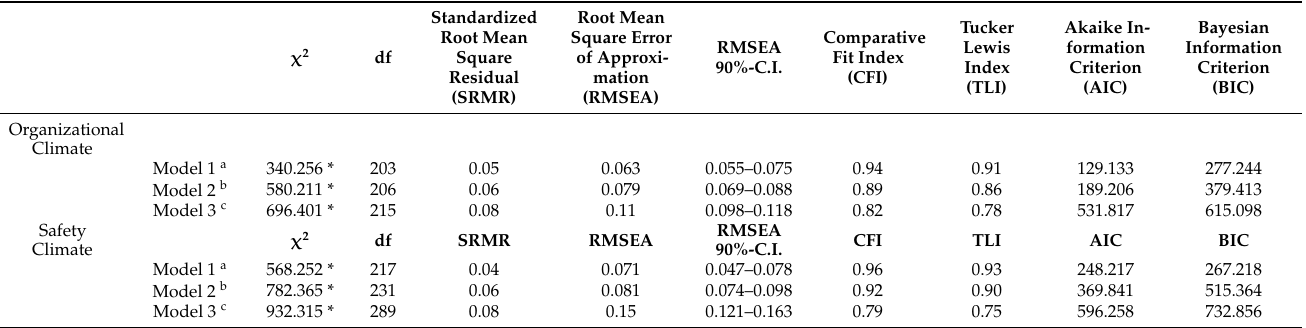
Table 1. Fit indexes for models tested in CFA (Study 1).